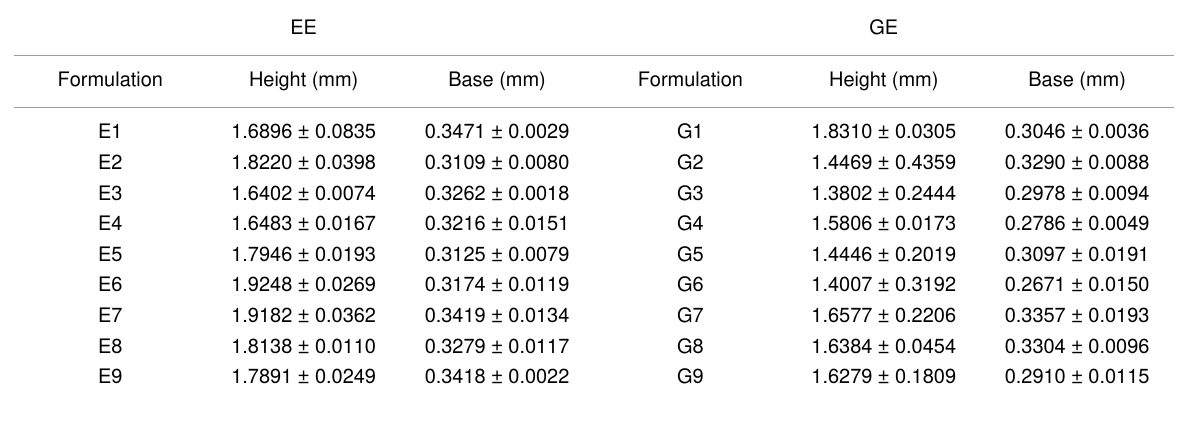
Table 1: Size analysis of microneedles containing ethanolic (EE) or glycolic extract (GE) of propolis.